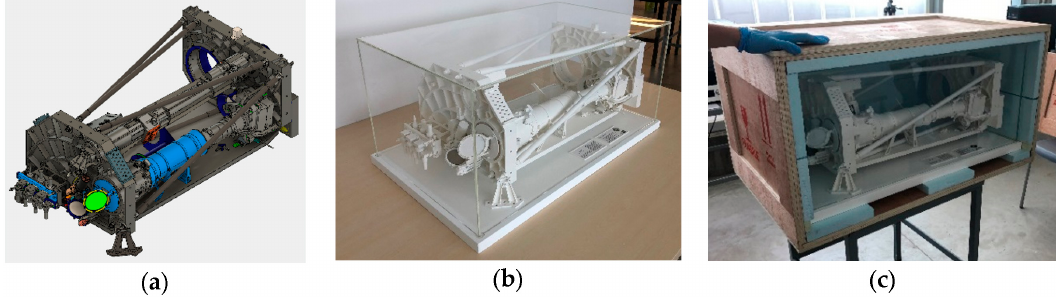
Figure 12. ( a ) SO / PHI digital model. ( b ) Final result of SO / PHI HDM. ( c ) HDM in its packaging.